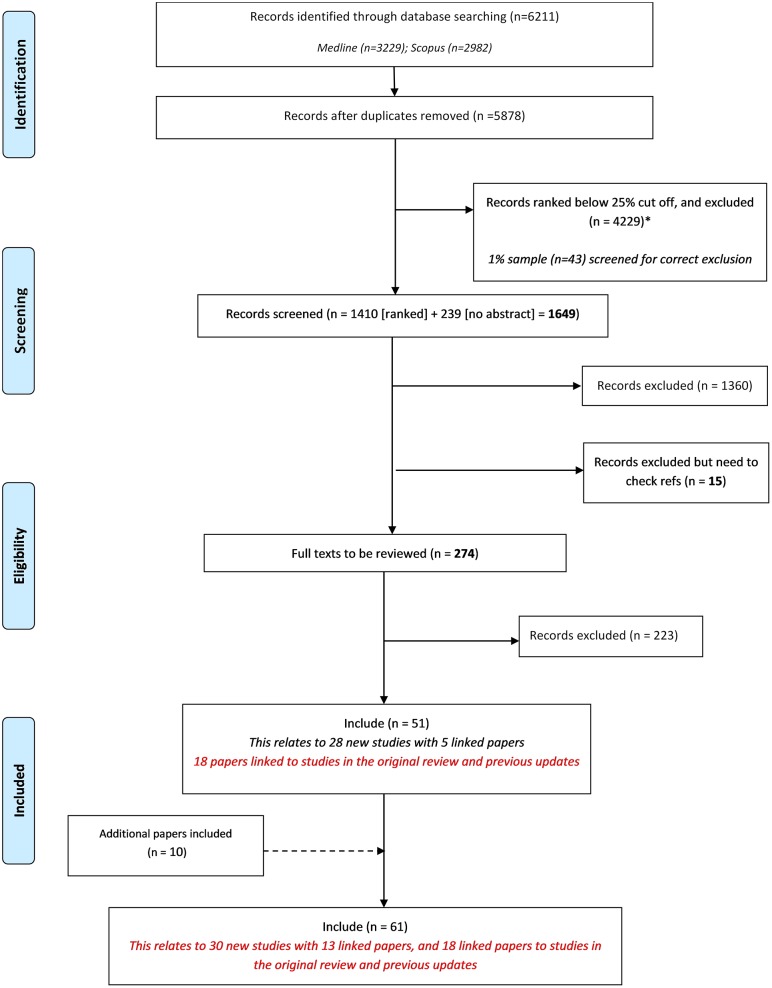
PRISMA flowchart.